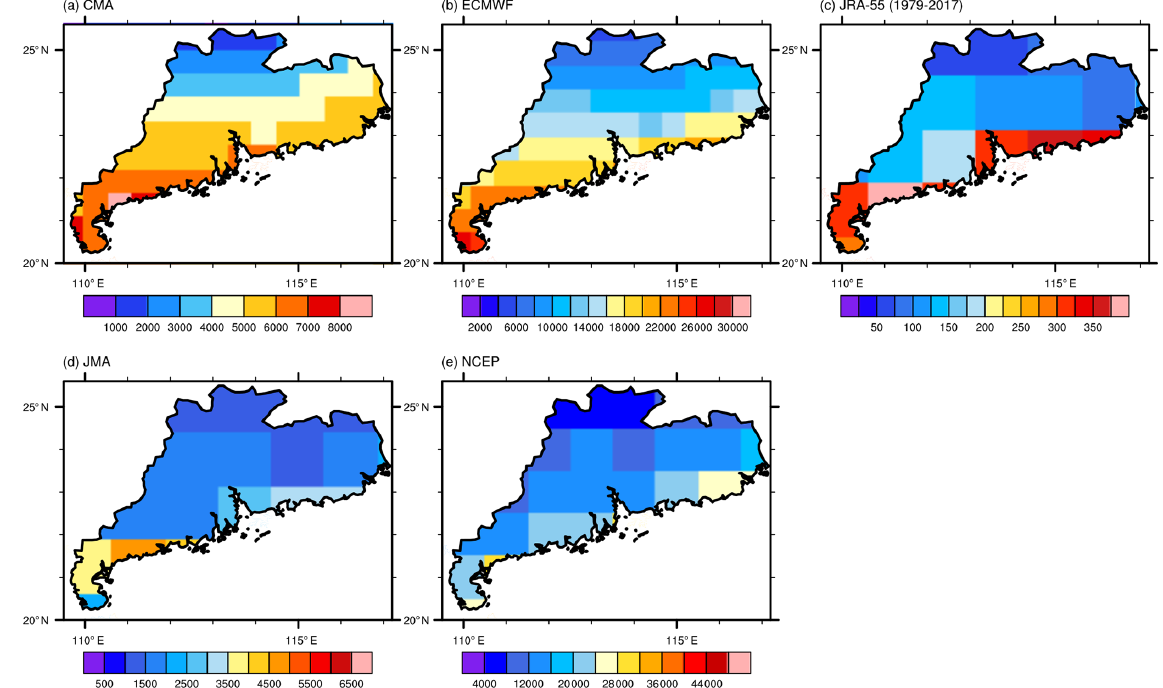
Figure 10. The number of TC-related 6-hourly data entries in each of the grid boxes in Guangdong Province, China, for the TPEPS TC event set and the JRA-55 event set.